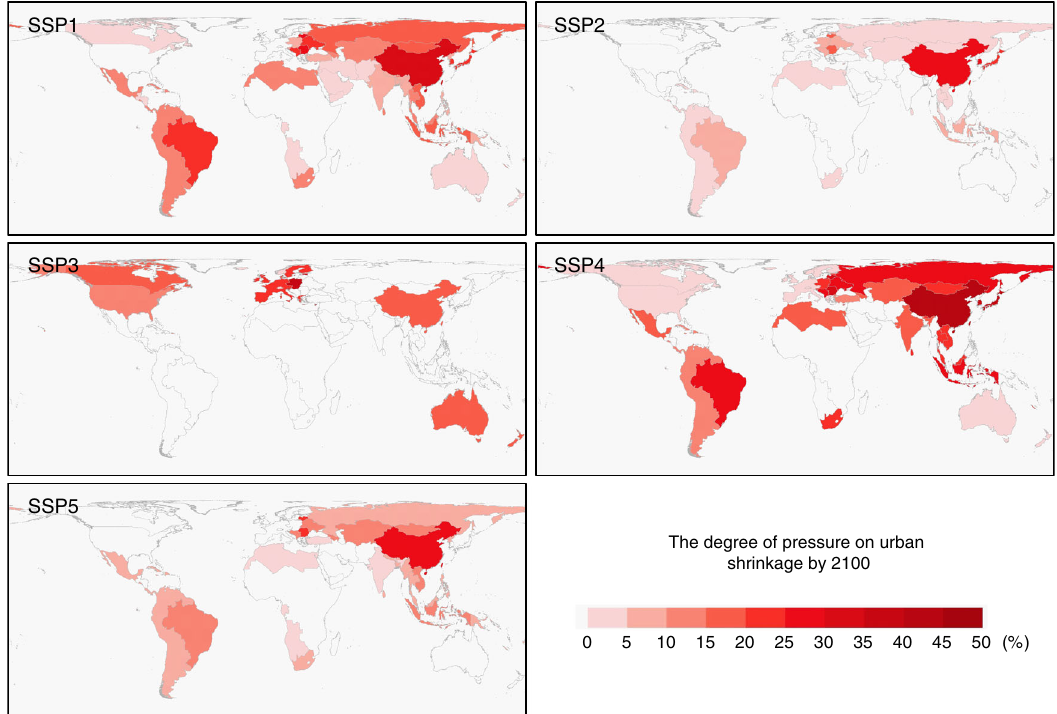
Fig. 7 The pressure of urban population decline by 2100. This fi gure shows the pressure of urban population decline by 2100 under fi ve SSP scenarios. This pressure is calculated as the percentage of the difference between the existing urban land area and the estimated urban land demand to the existing urban land area. Table 1 Contributions of various land covers to newly developed global urban land by 2100 under the SSPs